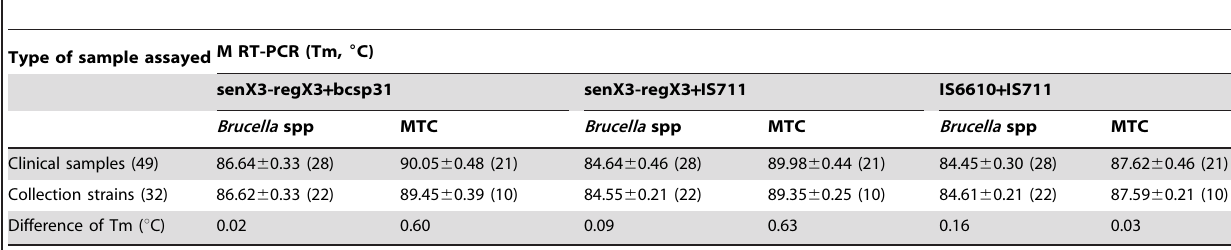
Table 6. Amplicons Tm of the three M RT-PCR assayed in different clinical samples and collection strains. 6 C) Type of sample assayed M RT-PCR (Tm,